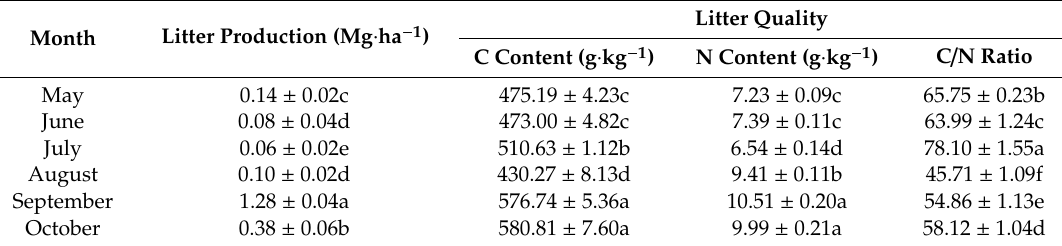
Table 2. Monthly dynamics of litter production and quality of the Larix gmelinii forest.